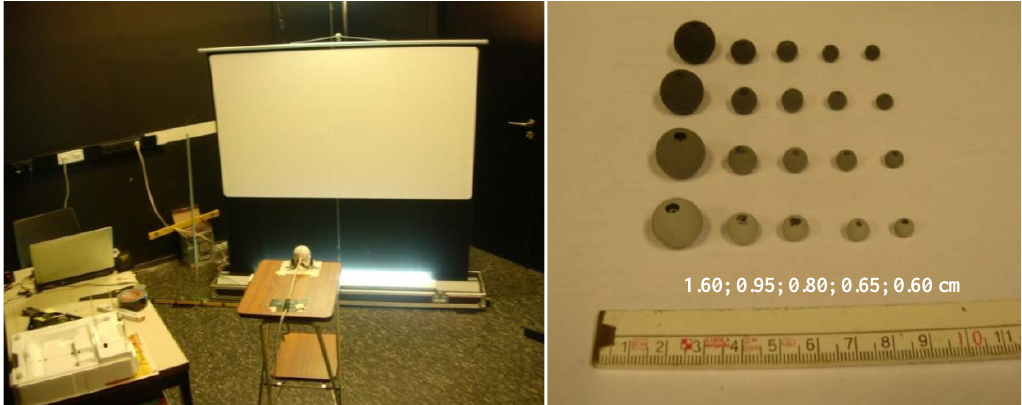
Figure 2. Left: Recording set-up of the pendulum in front of the projection screen and the Logitech webcam. Right: Various sizes (diameter in cm given in white) and colors of pearls used to analyze the effect of size, speed and contrast on the detection capabilities of a simple